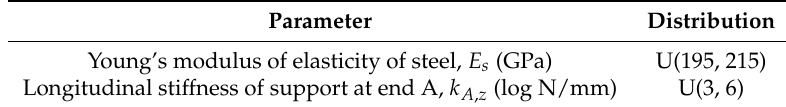
Table 1. Prior uncertainty distributions of parameters included in the FE model. The model parameters were assumed to have a uniform distribution (U).